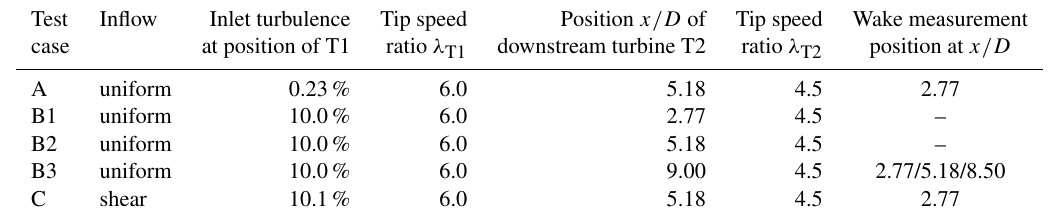
Table 2. Overview of turbine operating conditions downstream turbine positions as well as wake measurement positions for the five different test